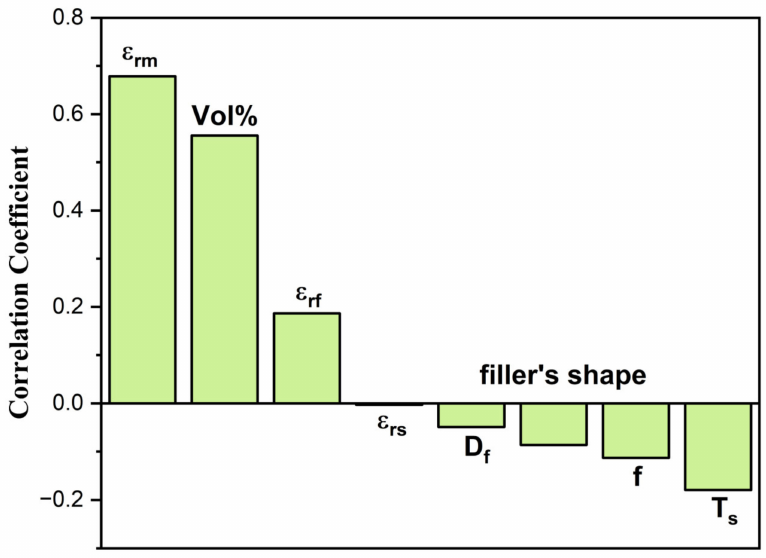
Figure 6. Pearson coefficients between the eight input variables and composite’s dielectric